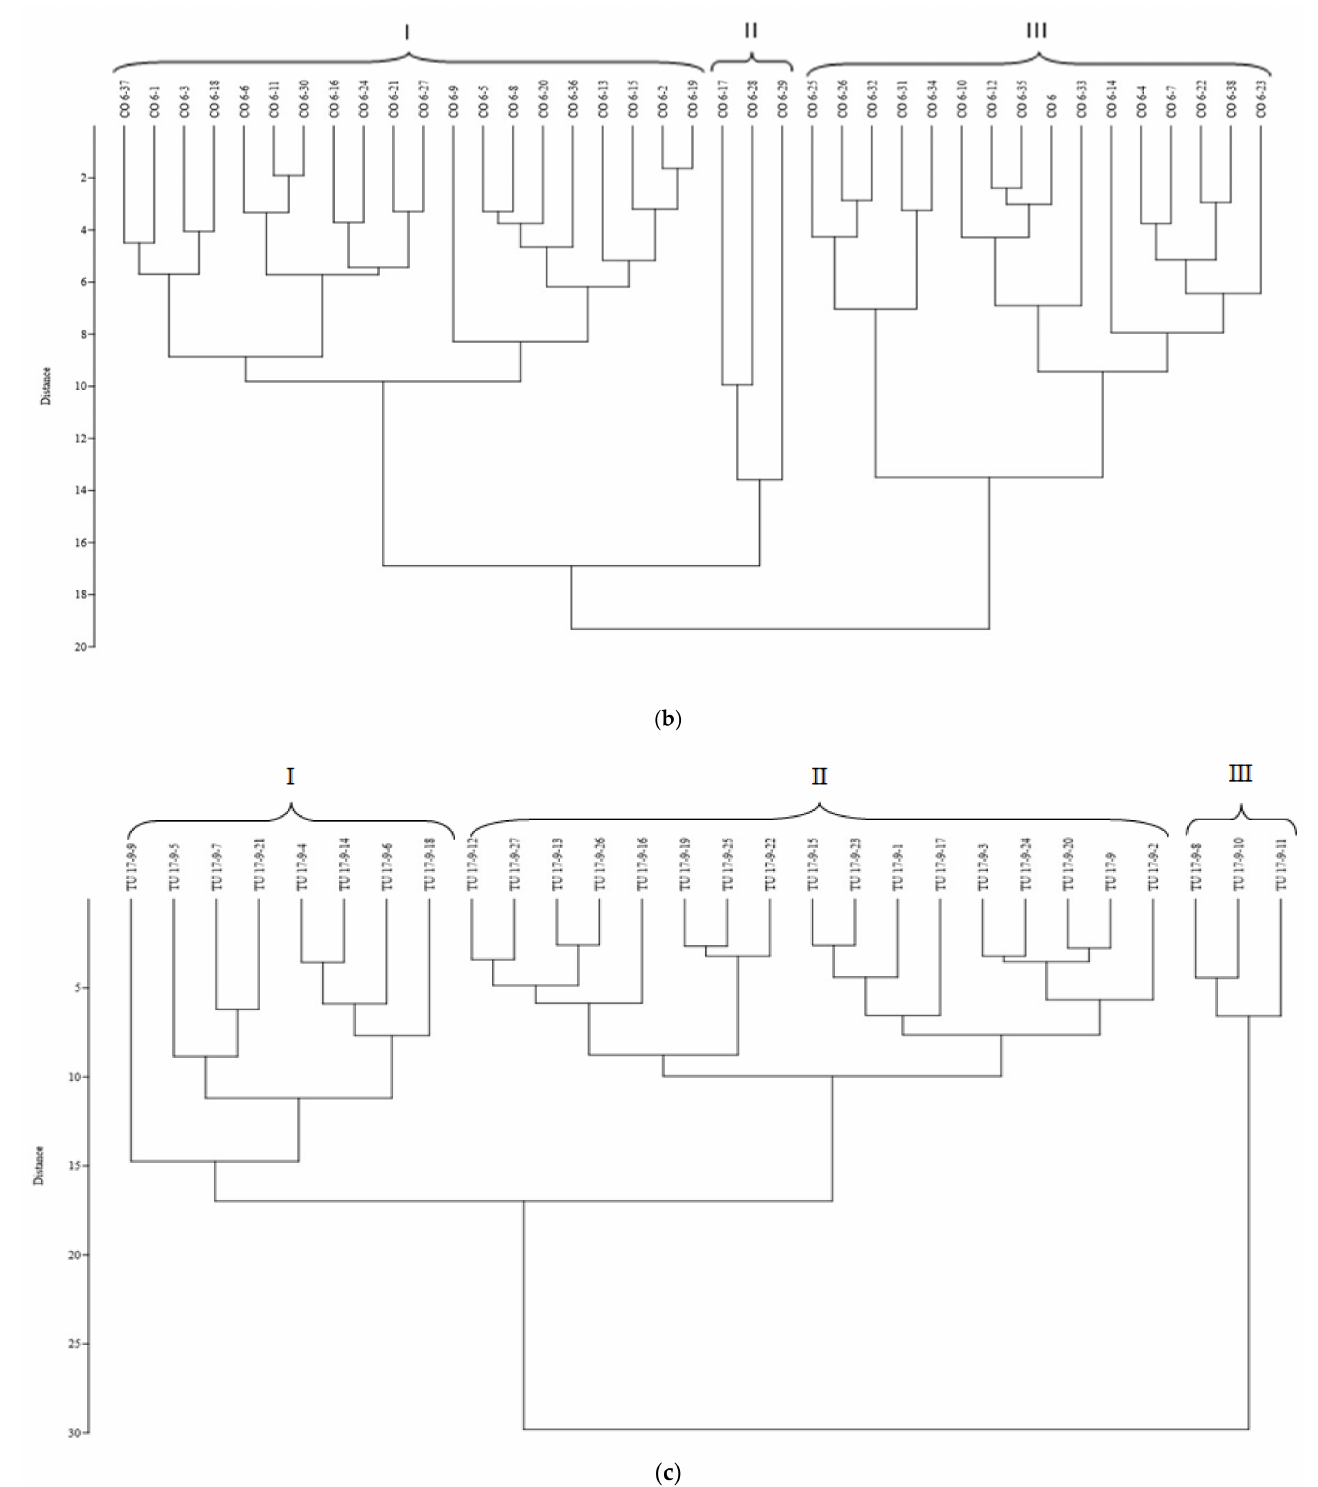
Figure 4. Dendrograms of blackgram mutant population clustering based on nine yield-related traits: ( a ) dendrogram using Euclidean similarity index and UPGMA algorithm for cv. ADT 3 mutant population; ( b ) dendrogram using Euclidean similarity index and UPGMA algorithm for cv. Co 6 mutant population; ( c ) dendrogram using Euclidean similarity index and UPGMA algorithm for cv. TU 17-9 mutant